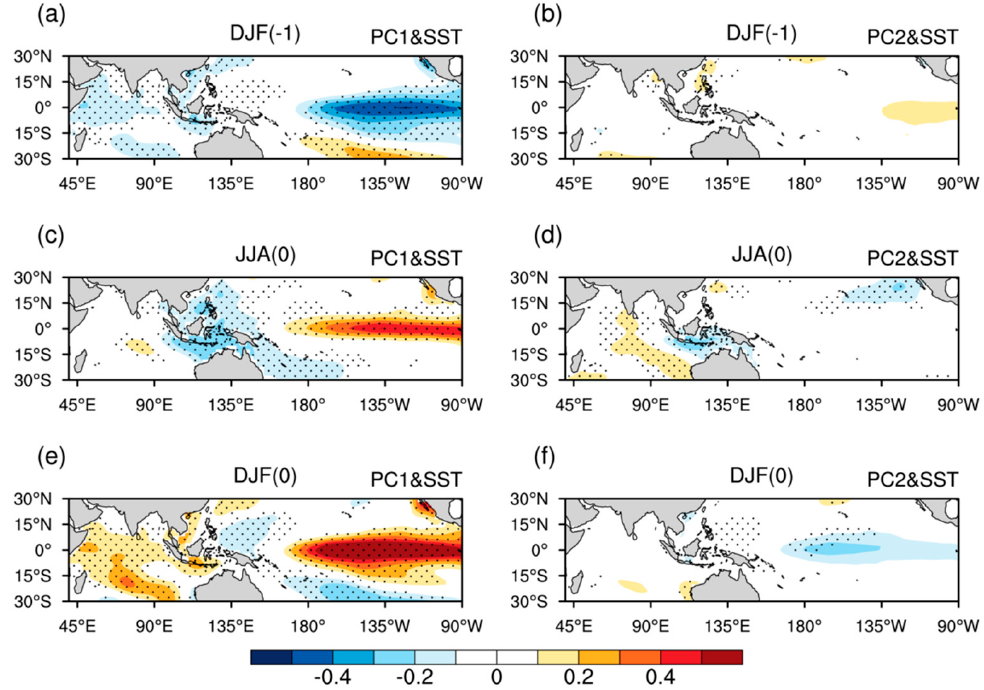
Figure 5. Linear regression slopes of SST (shaded; ◦ C) over the tropical Indian Ocean and Pacific in the ( a ) DJF(–1), ( c ) JJA and ( e ) DJF onto PC1. ( b , d , f ) As in ( a , c , e ), but for PC2. The black dotted area exceeds the 95% confidence level.